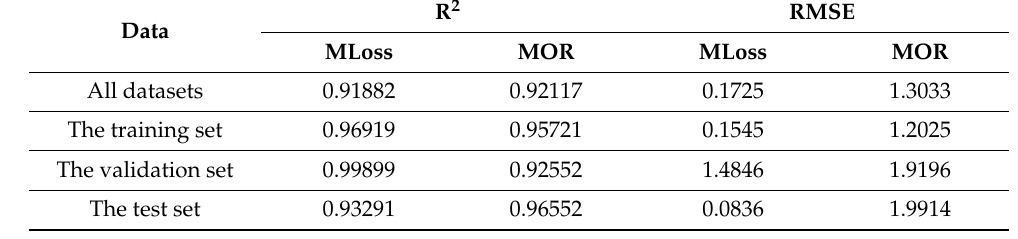
Table 2. The statistical metrics of the ANN model used to predict the modulus of rupture (MOR) and mass loss (MLoss) of fiberboard [98]. RMSE: root mean square error; R 2 : coefficient of determi- nation.